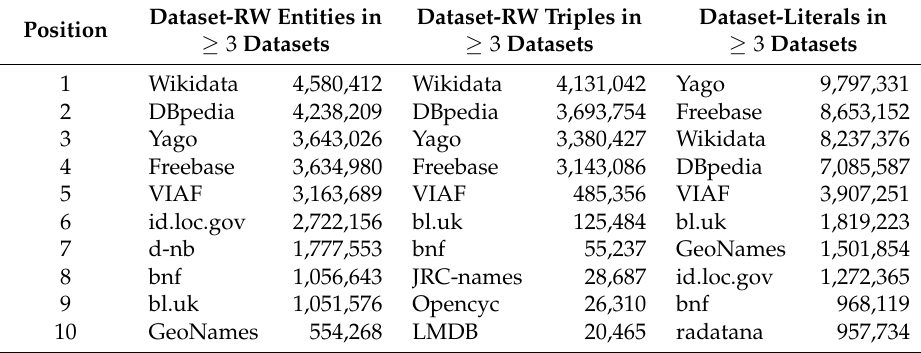
Table 12. Top-10 datasets with the most entities, triples and literals existing at least in 3 datasets. Dataset-RW Entities in Position 3 Datasets ≥